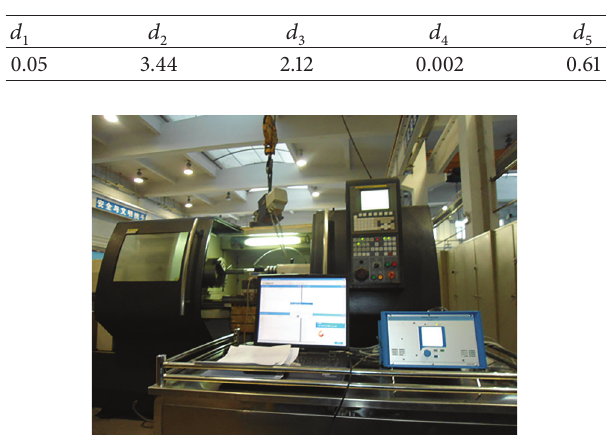
Table 2: The Johnson-Cook specified failure parameters of AISI-